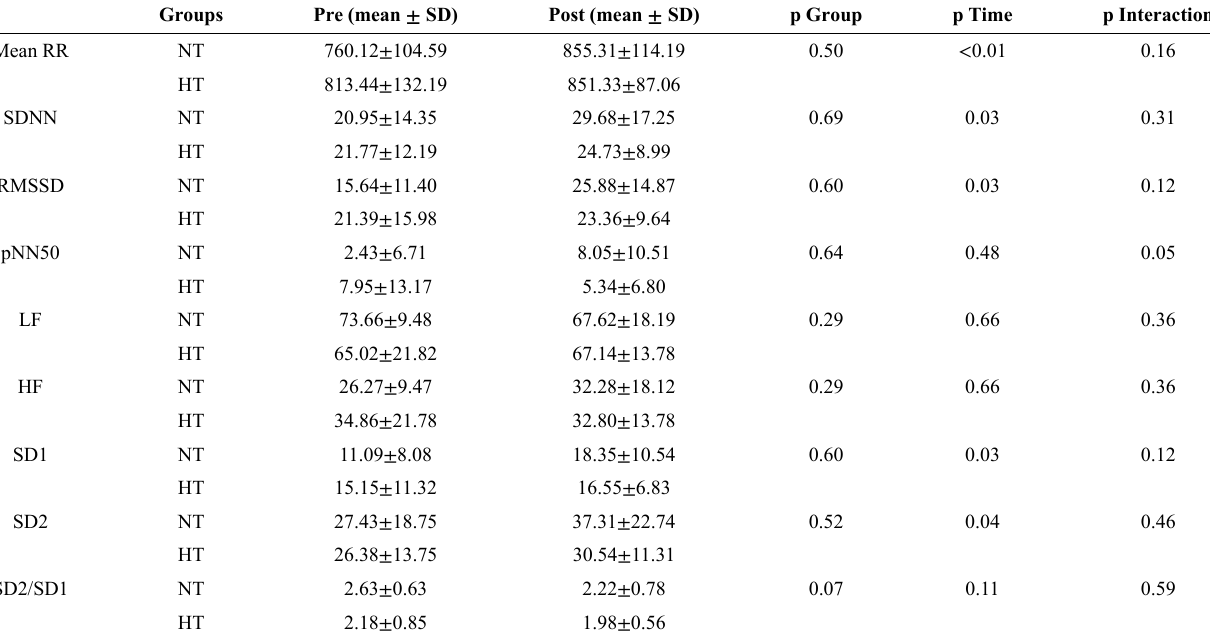
Table 2 - Heart rate variability parameters on normotensive and hypertensive postmenopausal